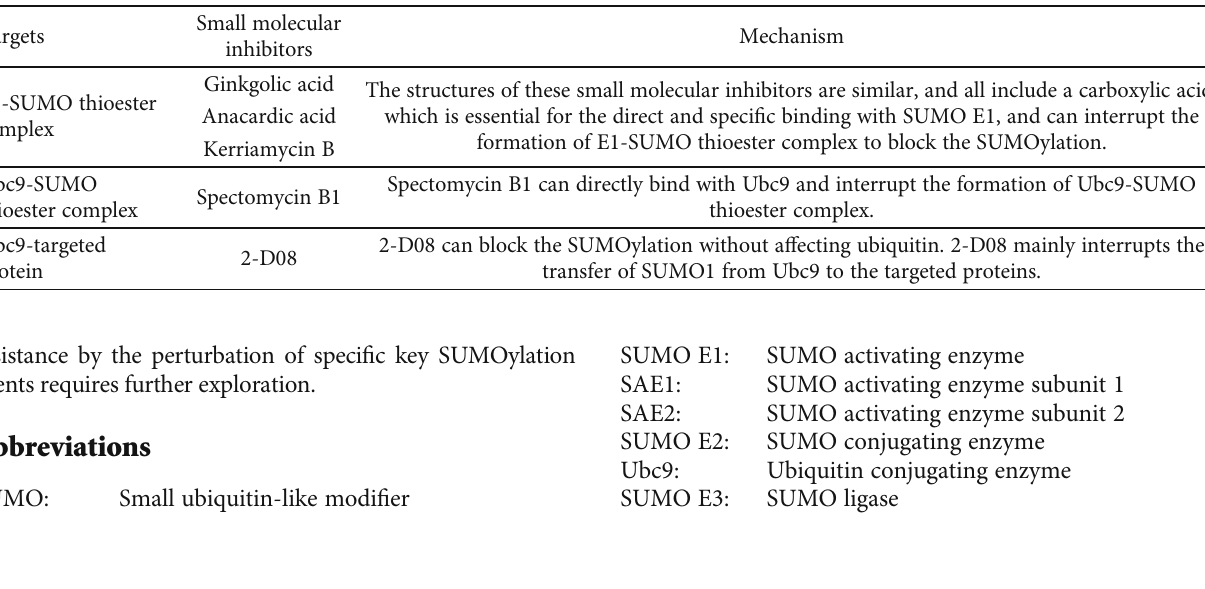
Table 3: The mechanism of SUMOylation